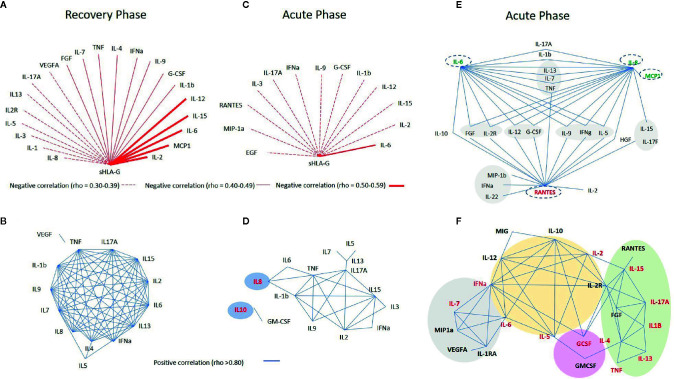
Networks constructed to evaluate the reciprocal influence among soluble mediators, evaluated in serum (A–D) and in cerebrospinal fluid (CSF) (E) of arbovirus infected patients exhibiting neurological manifestations during the acute phase of the infection (C–E) compared to the recovery phase (A, B), and between patients exhibiting or not neurological manifestations in the acute phase of the infection (F). In the networks shown in (D, F), names in red indicate serum molecules which levels were significantly higher in acute phase compared to the recovery phase in patients exhibiting neurological manifestations. In the E network, names written in red mean decreased, whereas those in green denote increased levels in CSF when compared to serum levels. Red lines denote negative and blue lines positive correlations as evaluated by the Spearman correlation coefficient test.